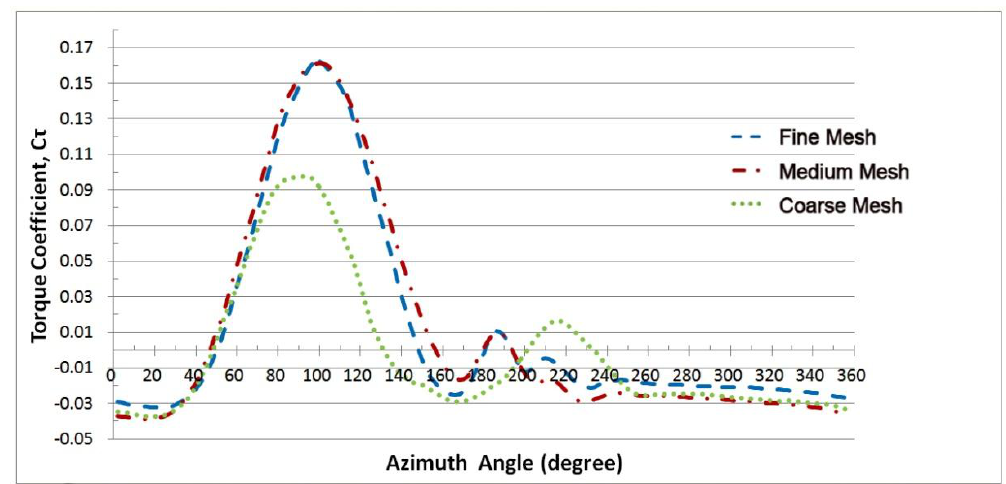
Figure 18. Diagram of the torque coefficient versus azimuth angles in the case of the coarse, medium and fine mesh.